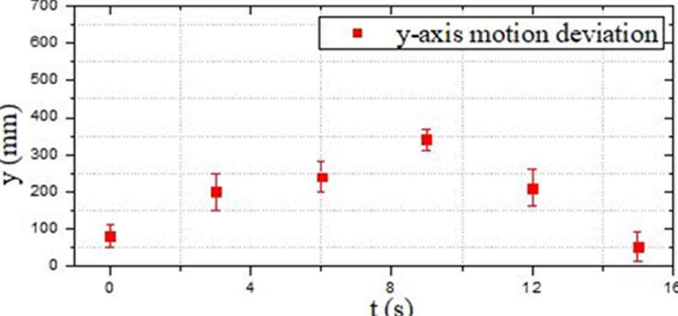
Figure 20. Motion deviation in the y-axis direction (the second experiment).